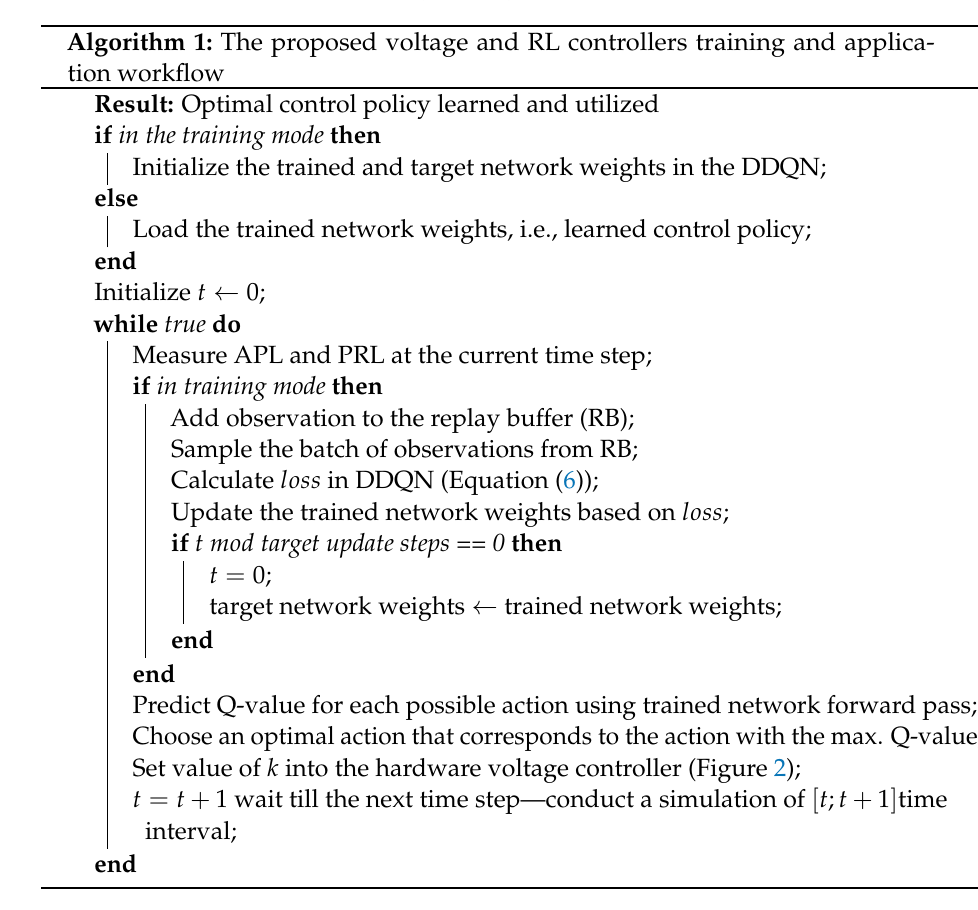
Algorithm 1: The proposed voltage and RL controllers training and applica- tion